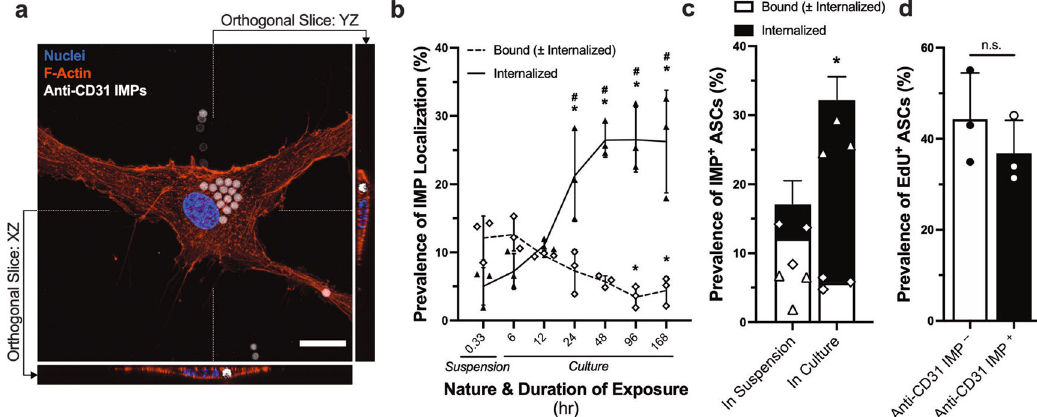
Fig. 6 Adipose tissue-derived stromal/stem cells (ASCs) bind and internalize anti-CD31 immunomagnetic microparticles (IMPs). a Intracellular localization of anti-CD31 IMPs in ASCs after 24 hr of culture. Scale bar represents 25 µ m. b Prevalence of IMP localization in ASCs after 20 min in suspension (i.e. labelling conditions for magnet-assisted cell sorting procedure) and different durations in culture. * p < 0.05 compared with respective localization in suspension; # p < 0.05 compared with membrane-bound localization. c Total prevalence of ASC interactions with anti-CD31 IMPs after 20 min in suspension vs. 48 hr in culture. Shown is a stacked bar graph depicting the total prevalence of ASCs exhibiting a membrane-bound and/or intracellular localization of anti-CD31 IMPs, and the corresponding proportions of each. Values represent mean ± standard deviation of the total prevalence. Triangles depict an internalized localization, and diamonds depict a membrane-bound localization. * p < 0.05 compared with suspension. d Incorporation of thymidine analogue 5-ethynyl-2'-deoxyuridine (EdU) during deoxyribonucleic acid (DNA) synthesis by IMP-laden and IMP-free ASCs after 48 hr in culture. ns represents not statistically signi fi cant. All values represent mean ± standard deviation. All experiments were performed in biological triplicate, using cells derived from three different donors ( n = 3 biologically independent